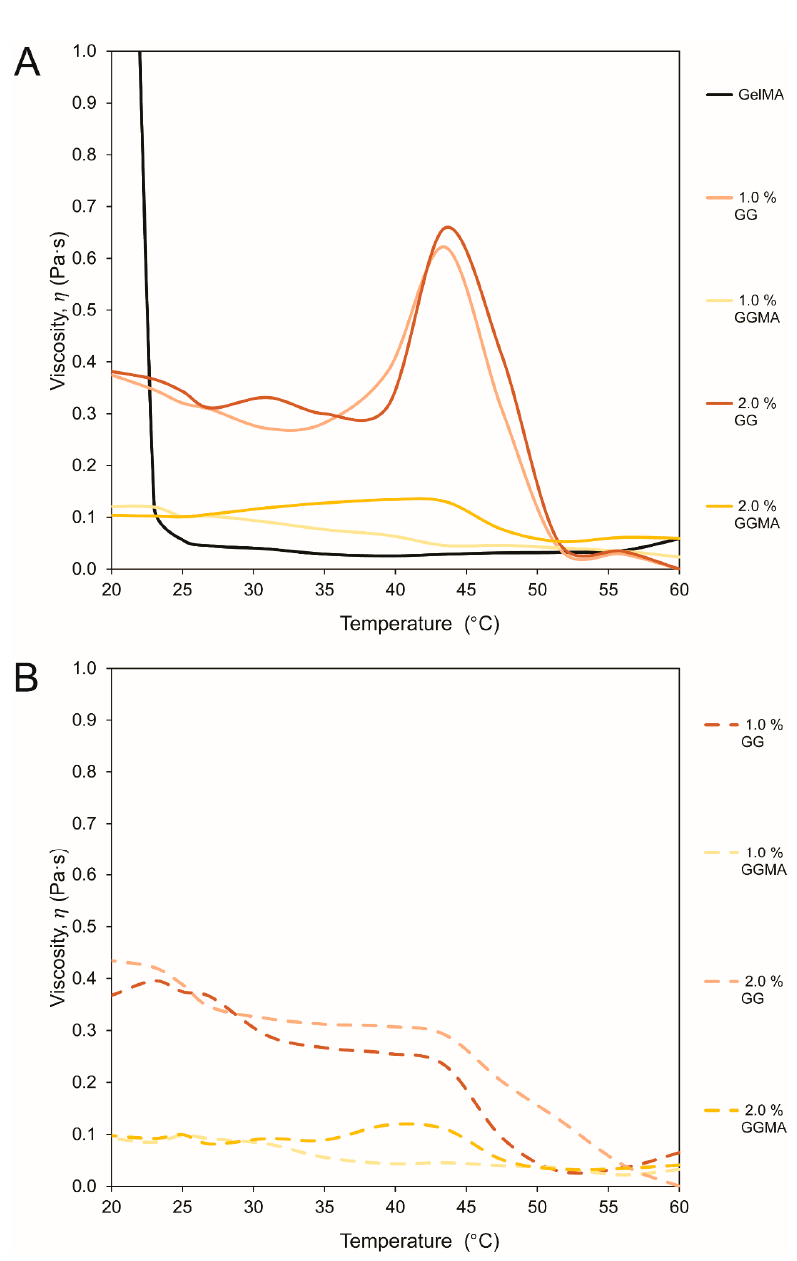
Figure 2. Rheological measurements of viscosity of hydrogel components. All samples were measured over the temperature range of 60–20 °C, with ( A ) PBS groups; and ( B ) NaCl + mannose groups. Colors are shared between PBS and NaCl + mannose gel groups, with the latter indicated by dashed lines. n = 1 in all cases.